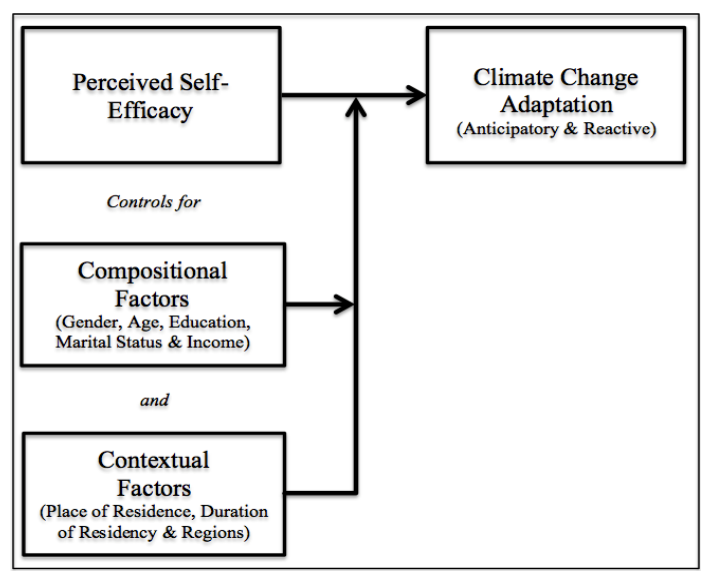
Figure 1. Perceived Self-Efficacy and Climate Change Adaptation (Source: Authors).